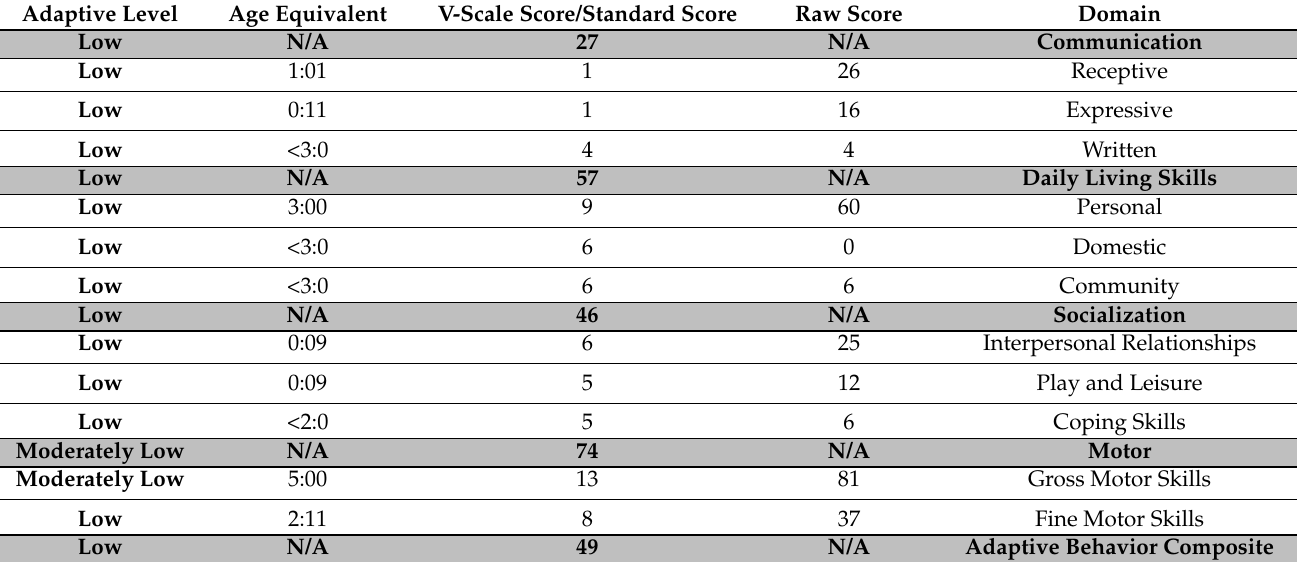
Table 3. Results of the Vineland-3 assessment of the